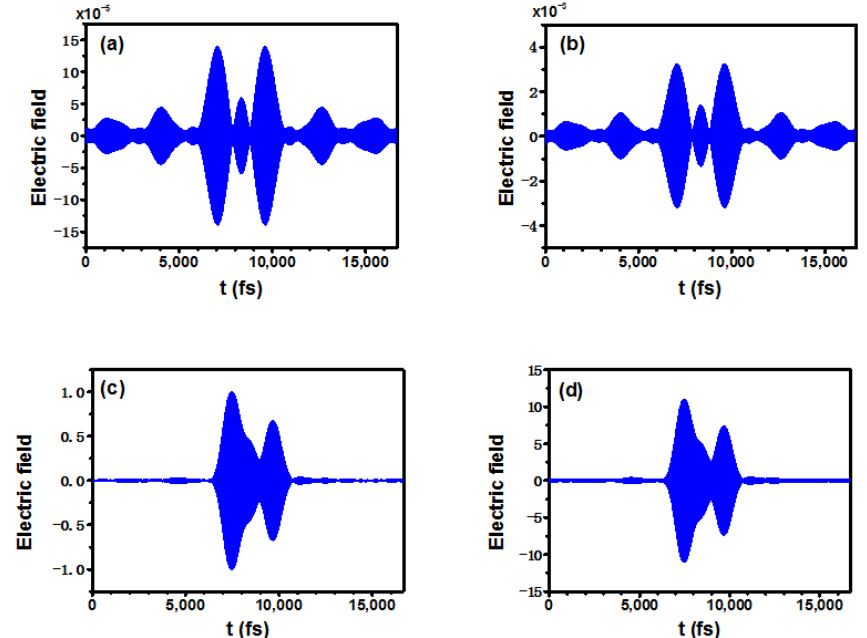
Figure A5. Real part of the electric field of ( a , b ) the Stokes and ( c , d ) anti-Stokes pulse when the step position of the Stokes light scans to 12,267 cm − 1 . ( a ) The input and ( b ) output of the Stokes pulse at the probe point of the disk-ring structure. The anti-Stokes pulse ( c ) in air and ( d ) at the probe point in the disk-ring structure.